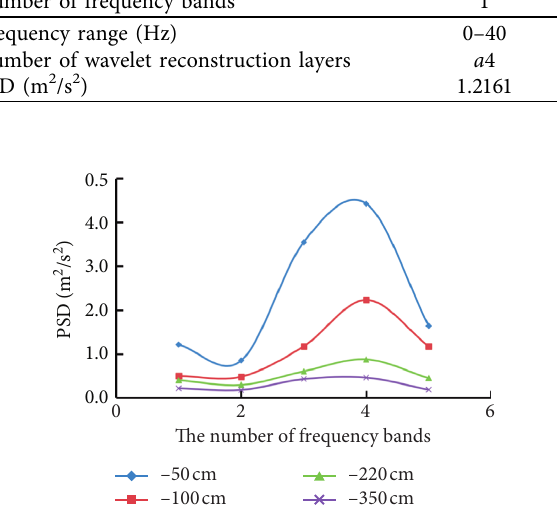
Figure 11: Distribution of vibration energy in different frequency bands of the test